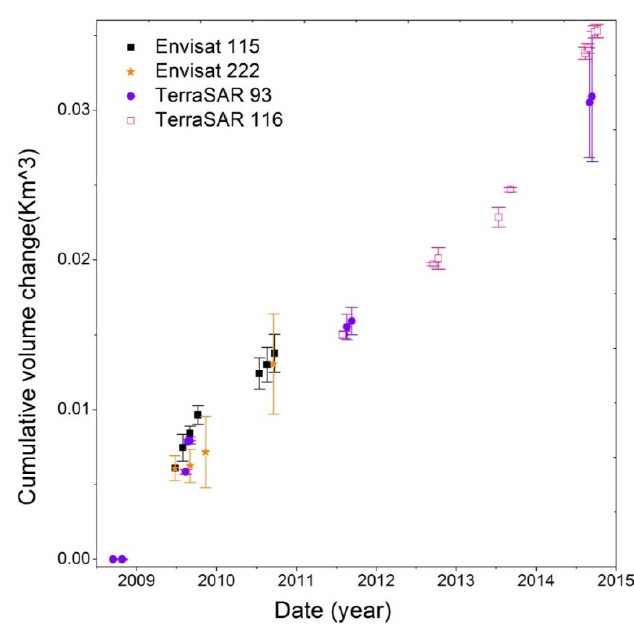
Figure 9. Modeled cumulative volume change beneath Okmok as a function of time from 2008 to 5 October 2014 for all four InSAR datasets. The volume of the first scene (20080914) is assumed to be zero.